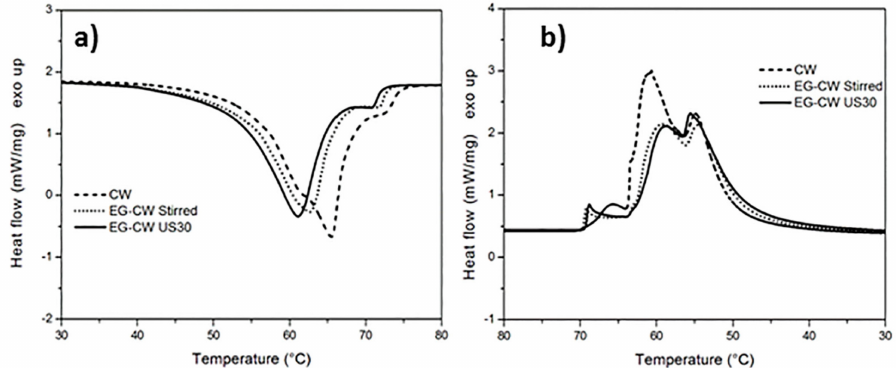
Figure 5. Dynamic DSC thermograms of candelilla wax (CW)–EG systems during: ( a ) heating and ( b ) cooling at 10 ◦ C / min.